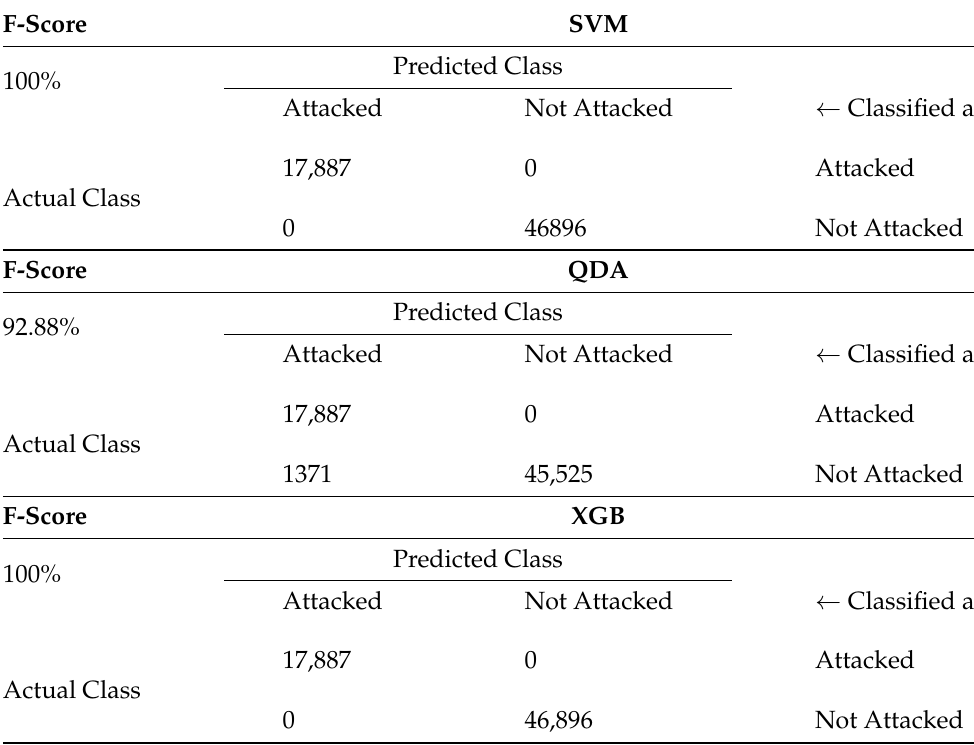
Table 8. Sample of the performance for scenario IV.